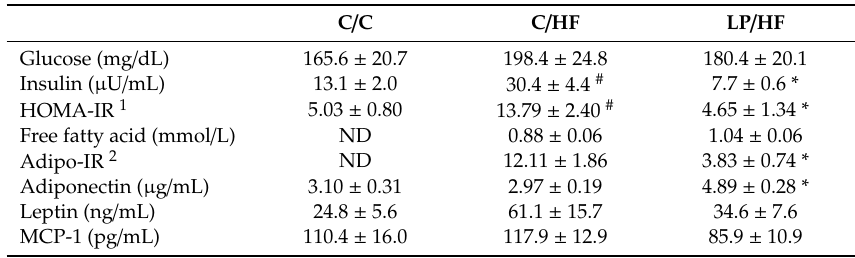
Table 2. Effects of maternal protein restriction during pregnancy and lactation on serum biochemical parameters of male offspring fed a high-fat diet.